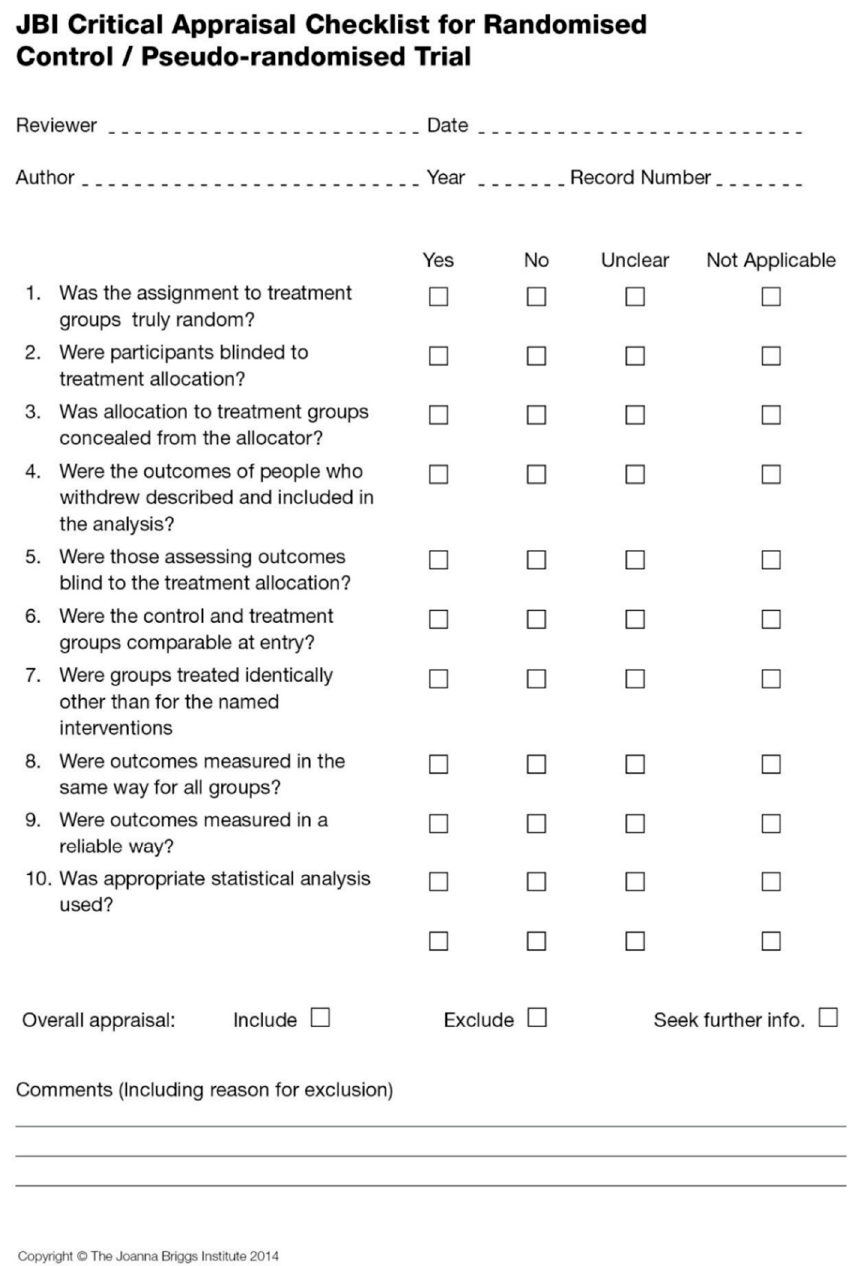
Figure A3. JBI Critical Appraisal Checklist for Randomised Cohort / Pseudo-randomised